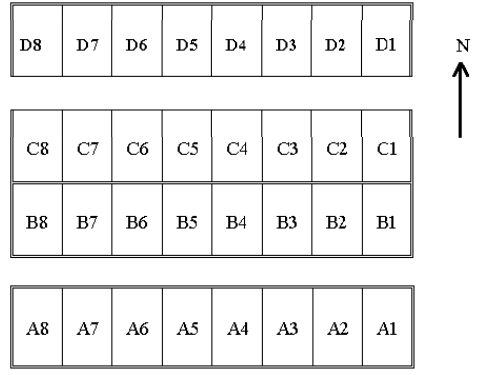
Figure 2. Layout of winter wheat and summer maize experimental plots.